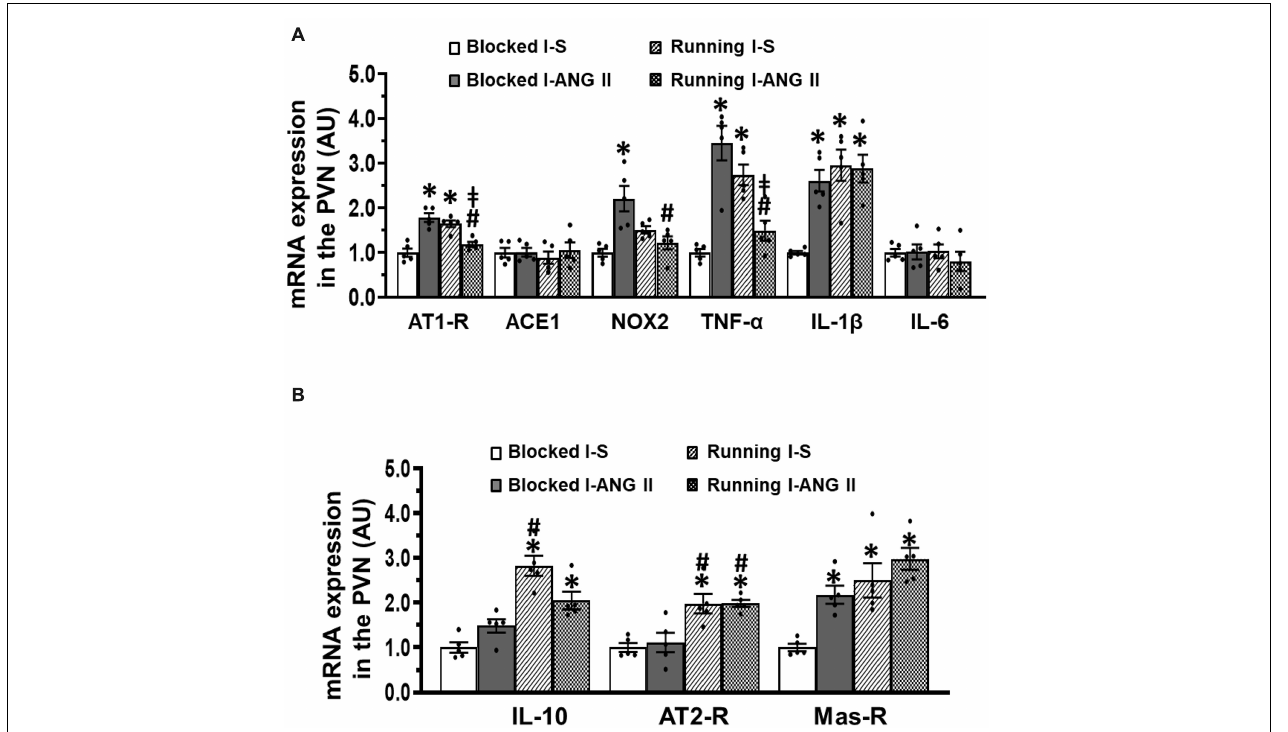
FIGURE 7 | Comparison of the mRNA expression of renin-angiotensin system components, NADPH oxidase and proinflammatory cytokines in the hypothalamic paraventricular nucleus (PVN) in sedentary (Blocked) or exercise (Running) rats after Delay period of the Induction-Delay-Expression (I-D-E) paradigm. (A) mRNA expression of prohypertensive components; (B) mRNA expression of antihypertensive components ( n = 5/group; one-way ANOVA was used for analysis followed by Tukey’s post-hoc tests; p < 0.05; ∗ vs. Blocked I-S; # vs. Blocked I-ANG II; } vs. Running